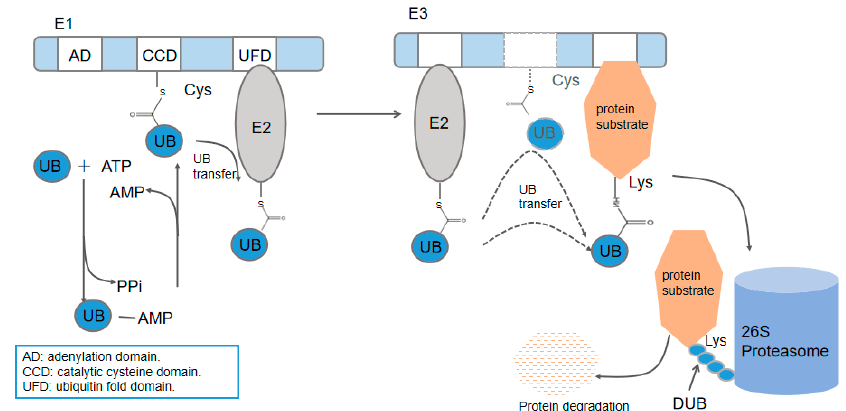
Figure 1. The attachment of ubiquitin (UB) to substrate proteins is carried out through an E1–E2–E3 cascade. UB is directly transferred from E3 to the substrate or from E2 with the mediation of E3. The dotted line indicates two different ways of E3 transfer.